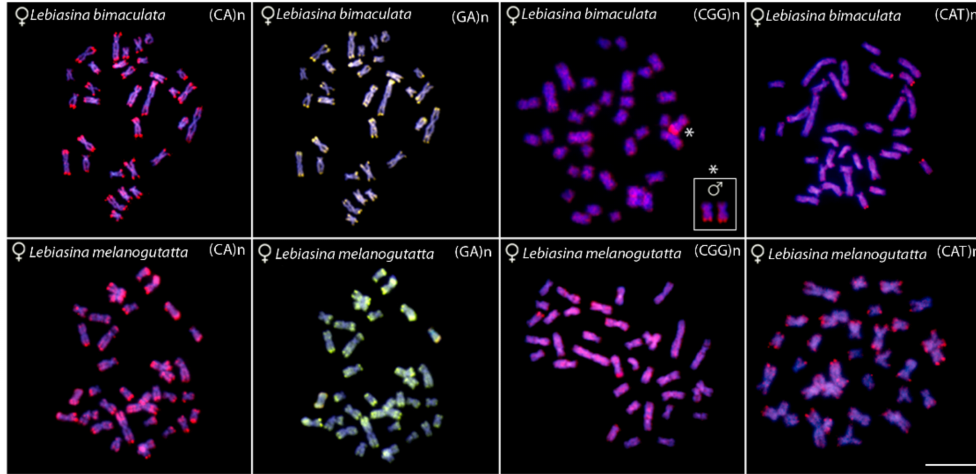
Figure 3. Metaphase plates of Lebiasina bimaculata (upper line) and Lebiasina melanoguttata hybridized with the microsatellite probes (CA)n, (GA)n, (CGG)n, and (CAT)n, respectively, showing the general distribution pattern of these repetitive DNAs in the chromosomes. Bar = 5 µ